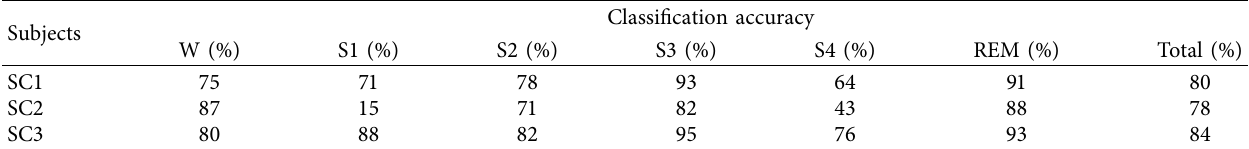
Table 3: Six-category staging results.